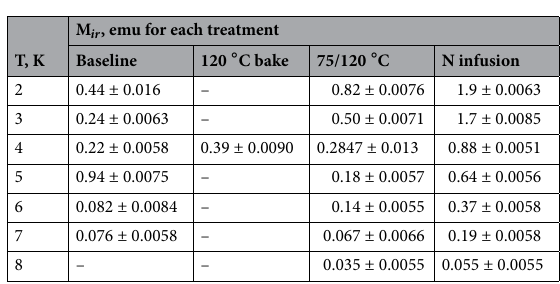
Figure 5. The hysteresis loops at 4.2 K for all four samples, with a magnified image in the top right for the residual moment when the μ 0 H ext = 0 mT.